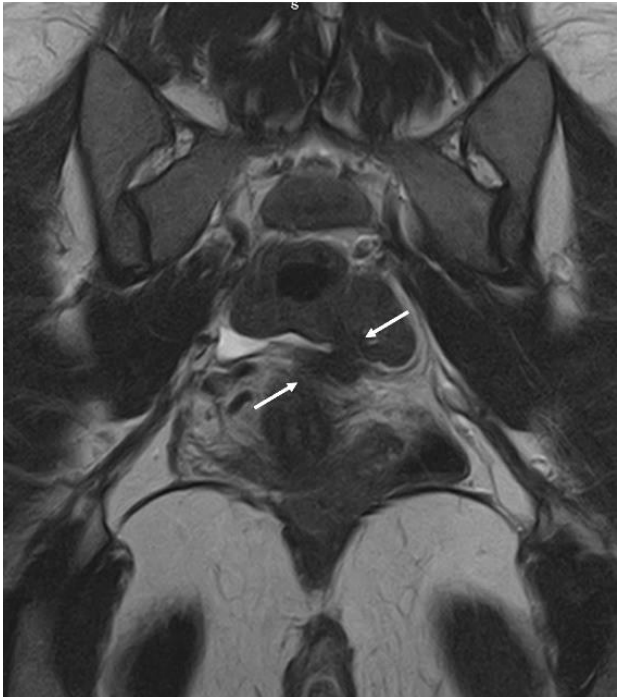
Figure 9. MRI imaging method: a nodule of the USL between the two arrows in the coronal plane.